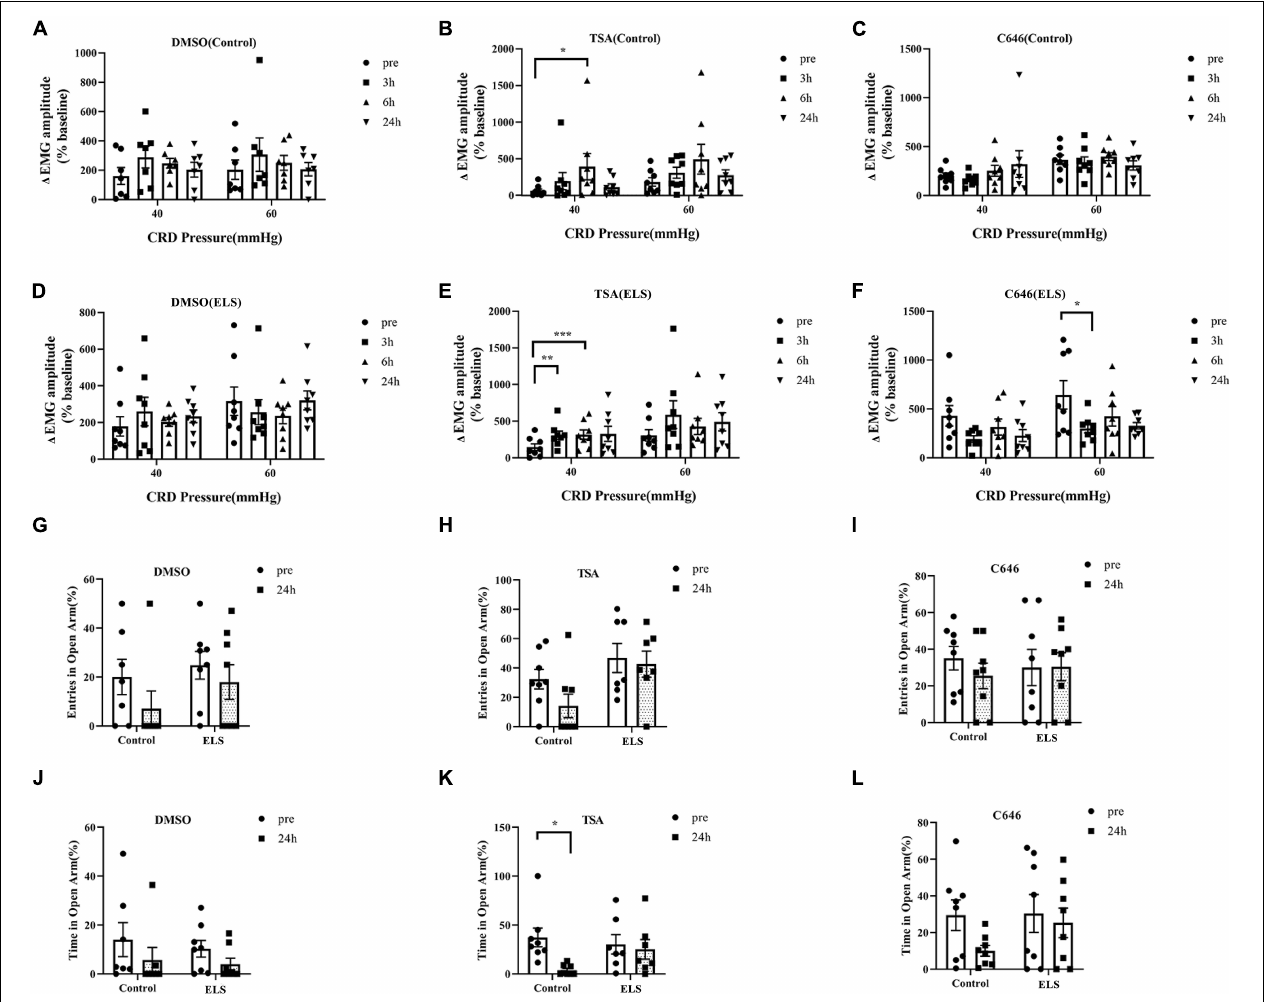
FIGURE 2 | Effects of TSA and C646 on pain and anxiety-like behaviors in rats. (A–F) Quantification of the amplitude of (cid:49) EMG response to CRD (40, 60 mmHg) before and after microinjection of DMSO (A) , TSA (B) , C646 (C) in control rats and DMSO (D) , TSA (E) , C646 (F) in ELS rats. (G–I) Quantification of entries in the open arms before and after the microinjections of DMSO (G) , TSA (H) , and C646 (I) in rats. (J–L) Quantification of time in the open arms before and after the microinjections of DMSO (J) , TSA (K) , and C646 (L) in rats. * p < 0.05, ** p < 0.01, *** p < 0.001. N = 7–8. A paired-samples t -test was performed (A,G–J,L) . A paired-samples t -test and Wilcoxon signed-rank test were performed (B–F,K) . N represents the number of rats per